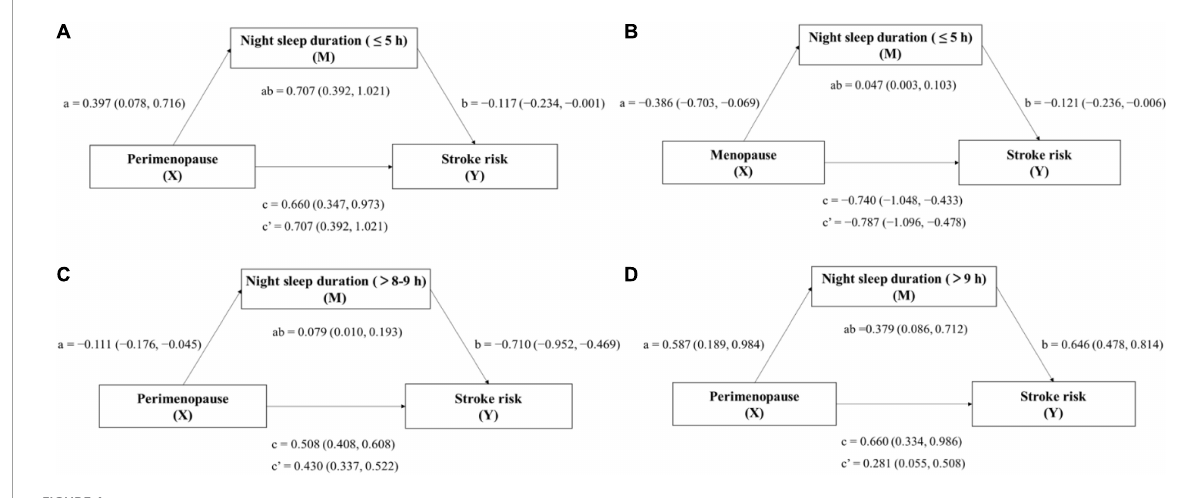
FIGURE4 Mediation model for the relationship between menopausal status and stroke risk, mediated by night sleep duration periods ( ≤ 5 h/ > 8–9 h/ > 9 h). Model (A) X: Perimenopause, M: Night sleep duration( ≤ 5 h), Y: Stroke risk; Model (B) X: Menopause, M: Night sleep duration( ≤ 5 h), Y: Stroke risk; Model (C) X: Perimenopause, M: Night sleep duration ( > 8–9 h), Y: Stroke risk; and Model (D) X: Perimenopause, M: Night sleep duration ( > 9 h), Y: Stroke risk. Paths a, b, c, and c (cid:48) are presented as unstandardized coefficients (95% CI). a = X on M; b = M on Y; c = total effect of X on Y; c (cid:48) = direct effect of X on Y; ab = indirect effect of X on Y. Covariates: age, education, marital status, and